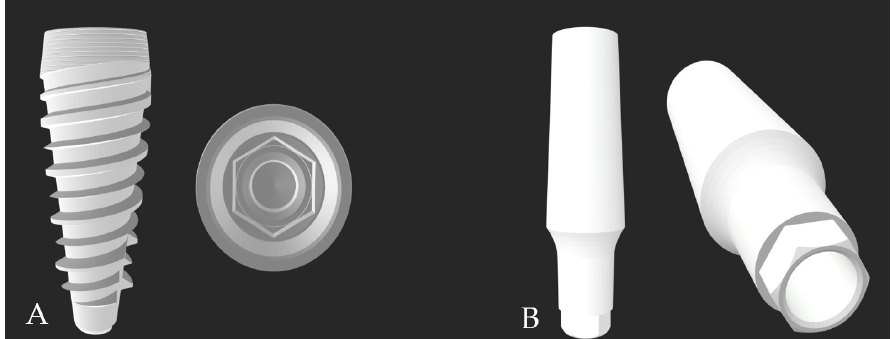
Figure 1. Experiment diagram.